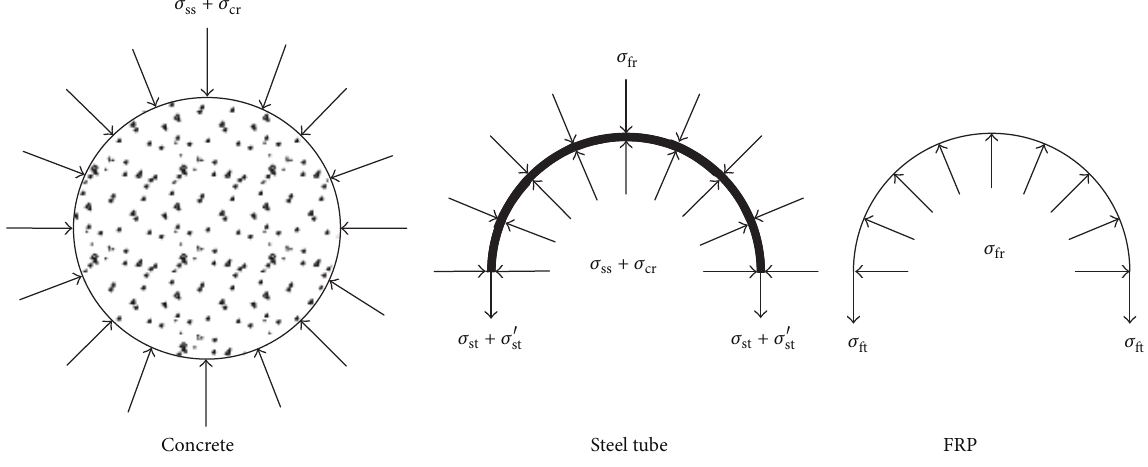
Figure 1: Stress distribution in